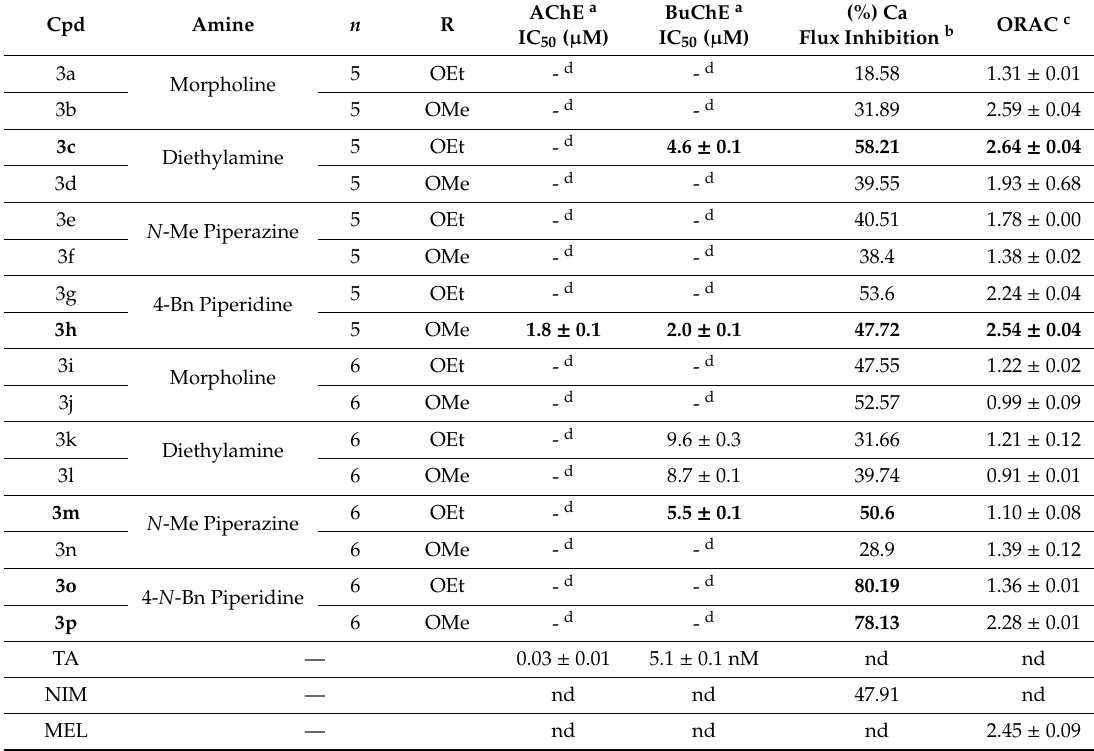
Table 1. ChE inhibition and calcium blockade percentages for compounds 2a-p , and their ORAC (TE)